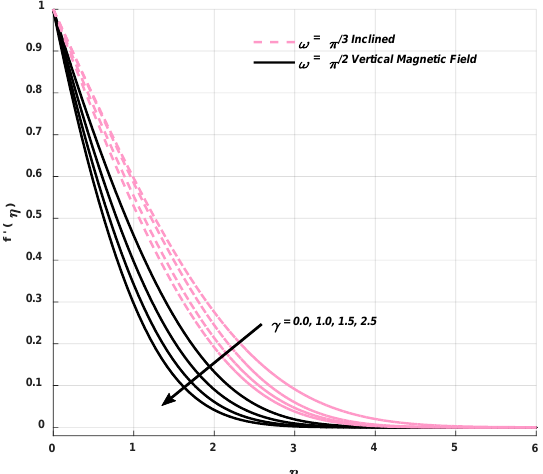
. . . ′ ′ ′ 𝑓𝑓 (𝛾𝛾) 𝑓𝑓 (𝛾𝛾) 𝑓𝑓 (𝛾𝛾)